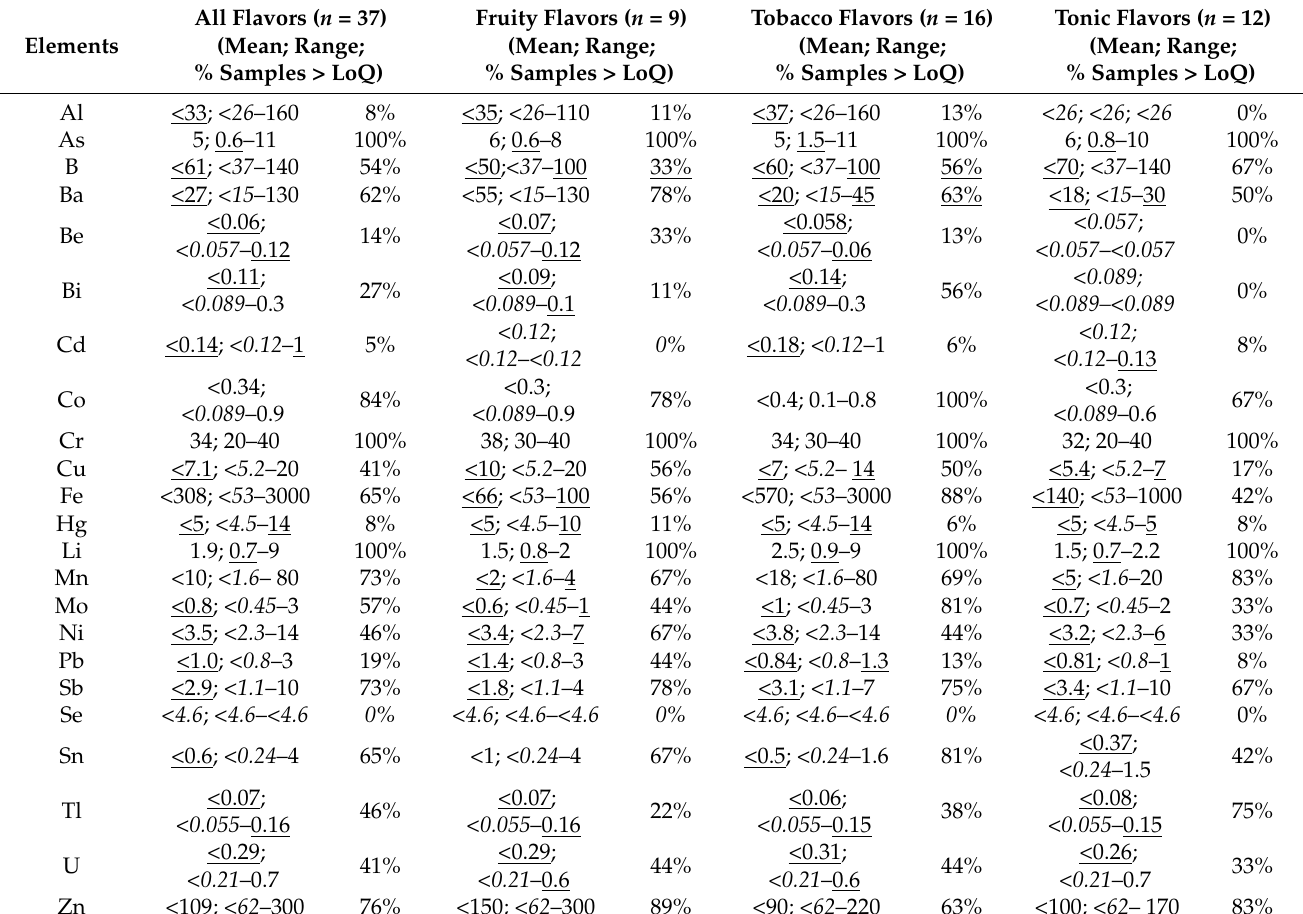
Table 3. Mean amounts, ranges (both in µ g kg − 1 ), and percentage of quantified samples (C > LoQ) in the determination of 23 toxic elements and oligoelements in 37 different